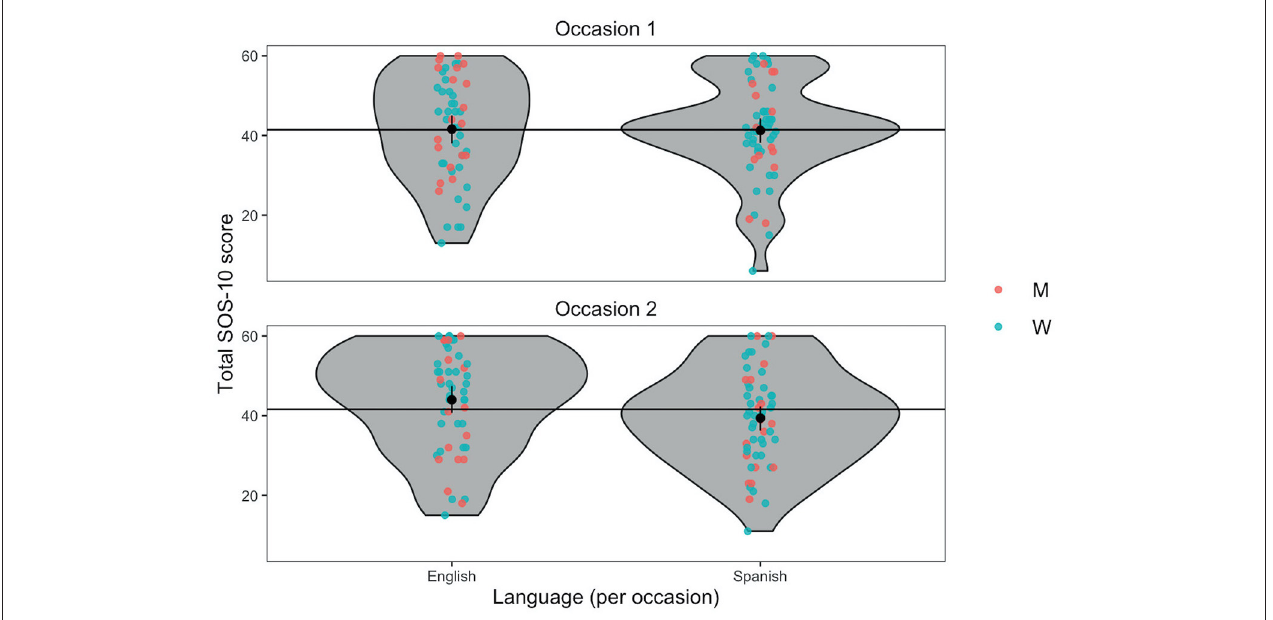
FIGURE 2 | Violin plot of SOS-10 scores by language, gender and occasion. Jittered points show individual scores by gender, horizontal reference lines are mean scores by occasion, and black points and error bars are language means within occasion with 95% bootstrap confidence interval. Points are jittered horizontally to minimize possible overprinting but not jittered vertically, so the scores are accurately represented. W, women; M,